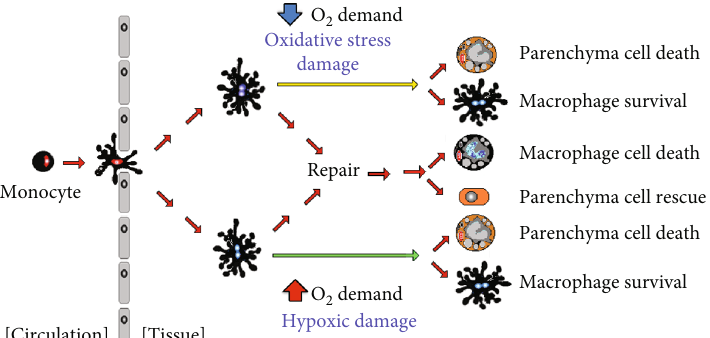
Figure 3: Schematic representation of parenchyma and macrophage cell fate in hypoxia and oxidative stress-in fl ammation